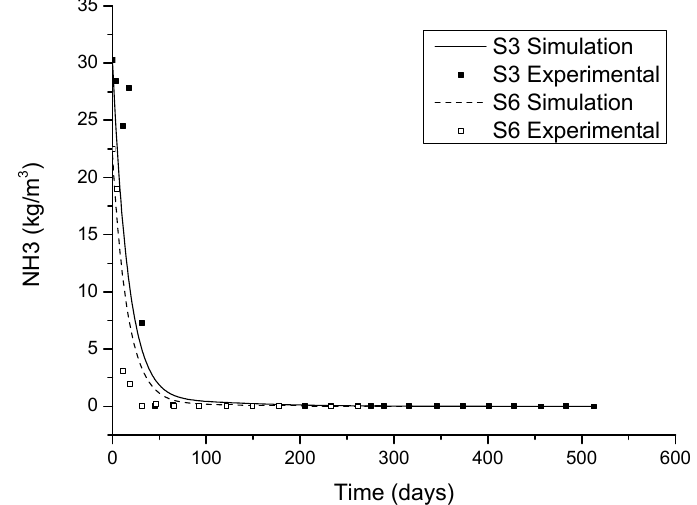
Figure 6. Time profiles of NH 3 degradation (experimental data cited in [35]).